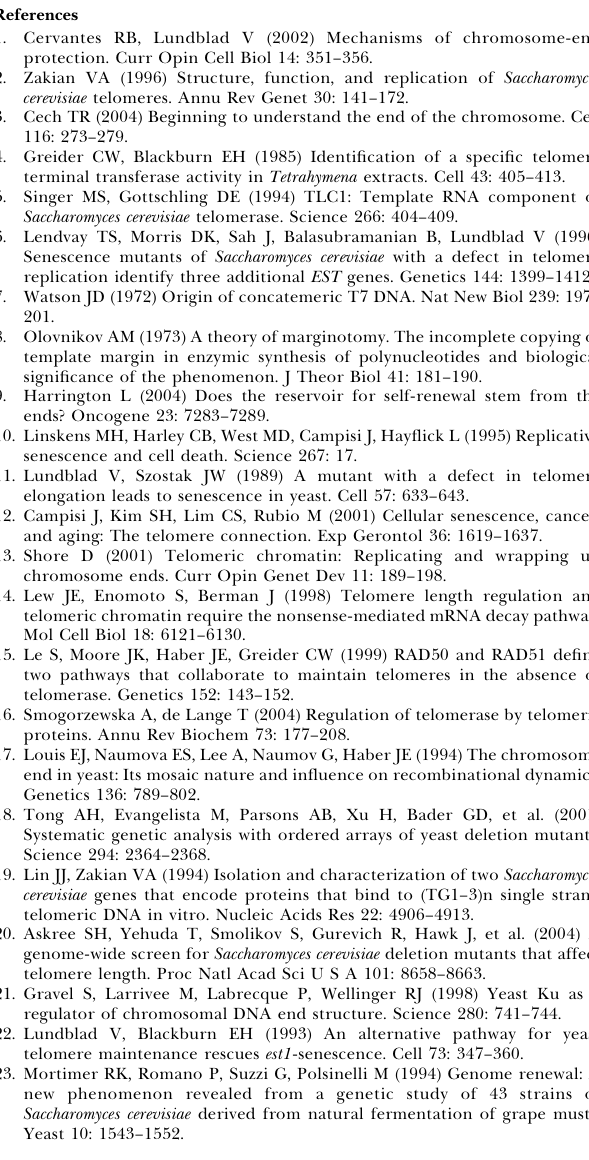
Table S1. Candidate Telomere Length-Control Genes in BY 3 RM11 Cross Found at DOI: 10.1371/journal.pgen.0020035.st001 (17 KB